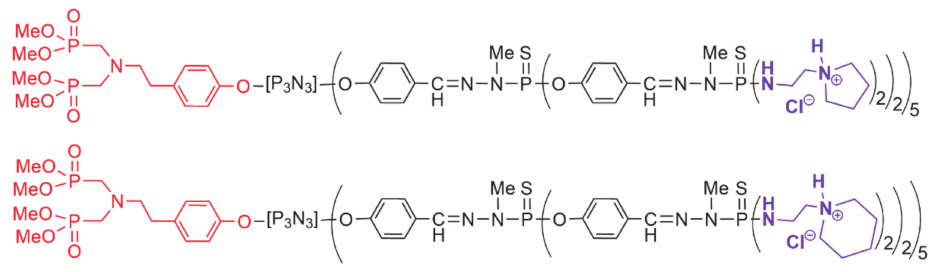
Figure 12. Structure of two dendrons having anti-cancer properties.